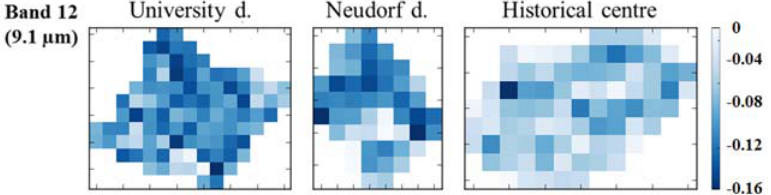
Figure 15. Difference between emissivity maps band 12 (9.1 µ m) derived using the proposed method and extracted from the ASTER Global Emissivity Dataset v3. Table 7. Maximum, Mean and standard deviation of the difference between emissivity estimated using the proposed method and the ASTER Global Emissivity Dataset v3 for each district (highest values in bold). Max ε Difference Mean ε Difference Std Dev. ε Difference